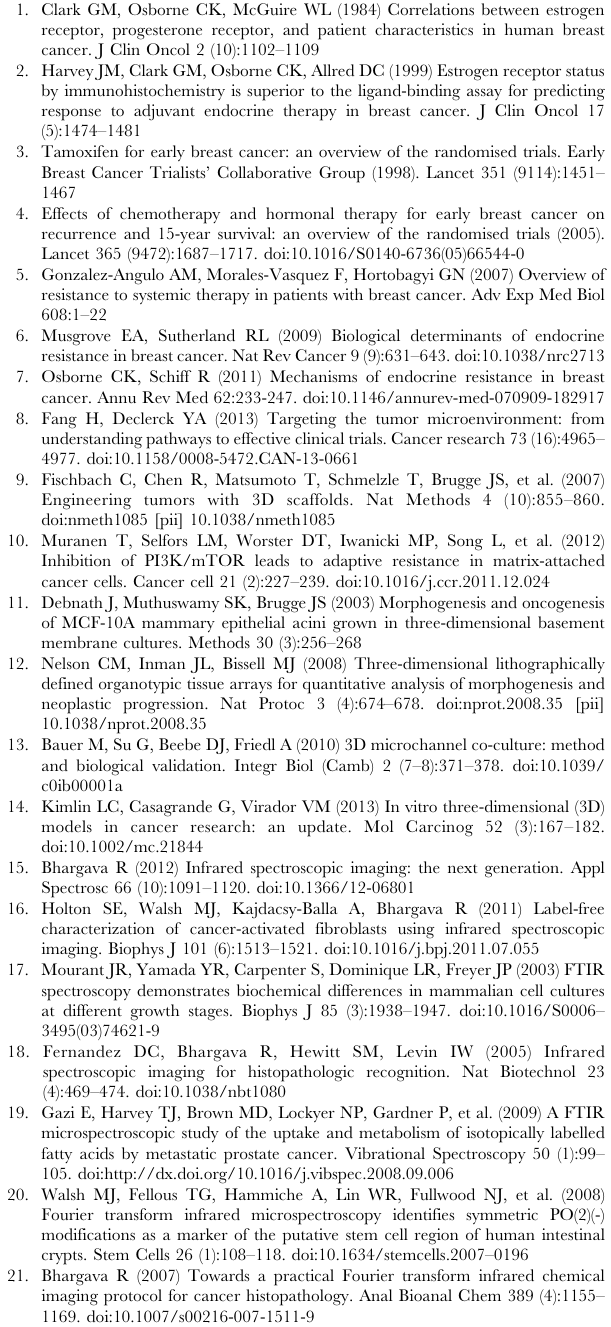
receptor (PR) and Ki67. Figure S4. Table of DAVID pathway association based on iSig. Figure S5. Table of ONCOMINE dataset patient characteristics. Figure S6. Expression of iSig is correlated with breast cancer stromal expression. Figure S7. FT- IR signature of E 2 response of MCF-7 cells is based on fibroblast density. Figure S8. FT-IR signature of E 2 response of MCF-7 cells is affected by treatment with CM. Figure S9. Fibroblasts recruited to the outside of MCF-7 spheroids display mild a -SMA staining.